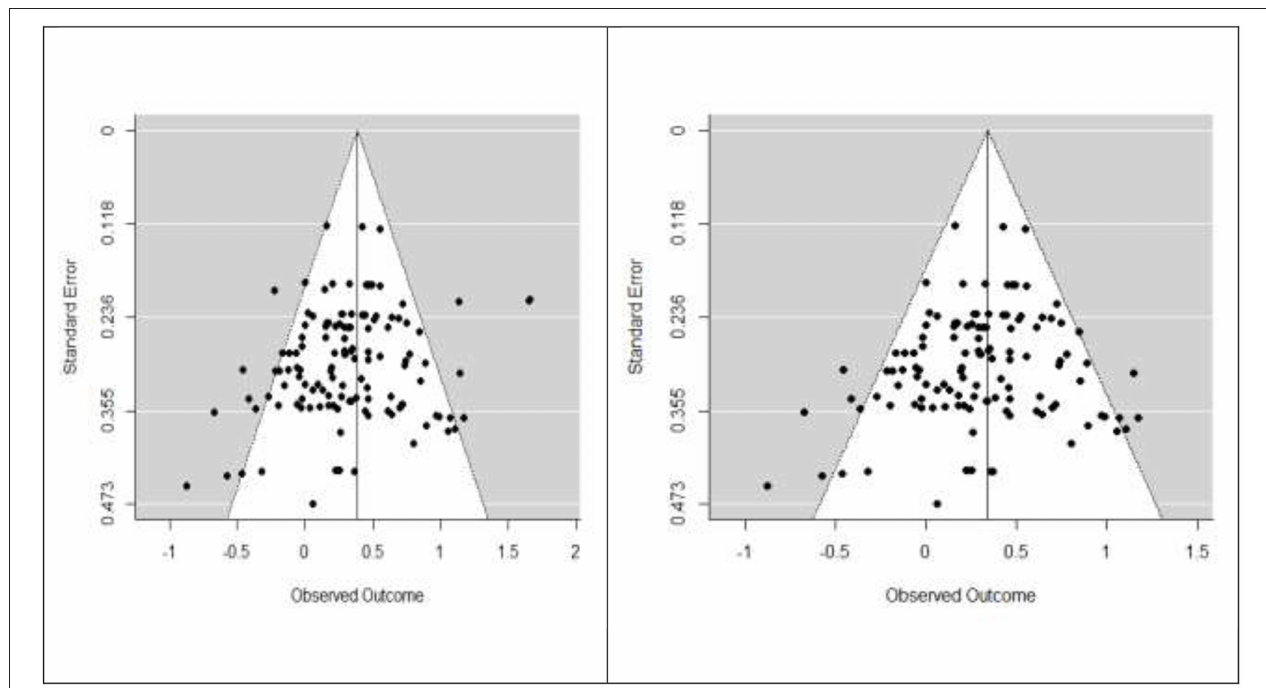
FIGURE 2 | Funnel plot of the meta-analysis of main outcomes of all studies (left) and of published studies (right) . Each plotted point represents the standard error and standardized mean difference (Hedge’s g) between control and Intervention group for a single outcome. The white triangle represents the region where 95% of the data points are expected to lie in the absence of publication bias. The vertical line represents the estimated effect size, based on the meta-analysis.